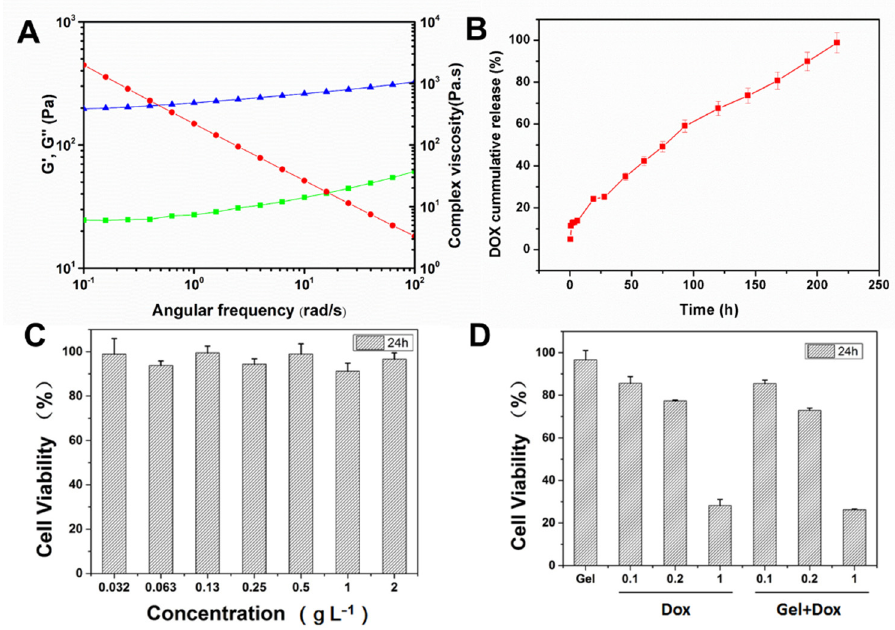
Figure 4. ( A ) G ′ (blue)and G ″ (green) modulus and viscosity (red) of DOX@HPC- g -AA/BSA hydrogel from frequency sweep; ( B ) the release kinetics curve (red) of DOX from DOX@ HPC-g-AA/BSA hydrogels; ( C ) in vitro cytotoxicity of HPC- g -AA/BSA hydrogel to 3T3; data are presented as the average ± standard deviation (n = 5); ( D ) cell viabilities of 4T1 cells after incubation with 5 μ L of HPC- g -AA/BSA hydrogel only (Gel), free Dox (Dox), and DOX-loaded hydrogel (Gel + DOX). The DOX concentrations in the free Dox or group were 0.1 mg/mL, 0.2 mg/mL, and 1 mg/mL, respectively. (n = 3).